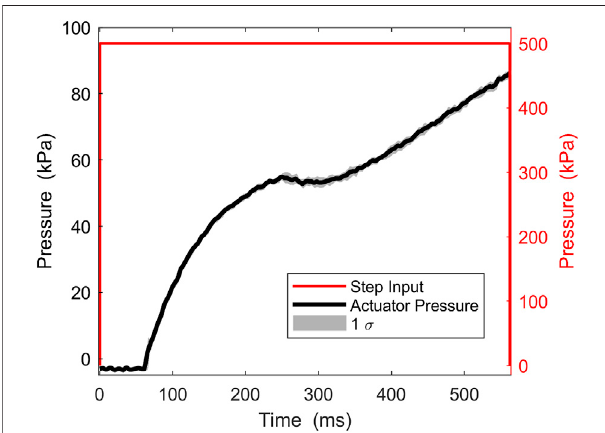
FIGURE 8 | Dynamic pressure test results.